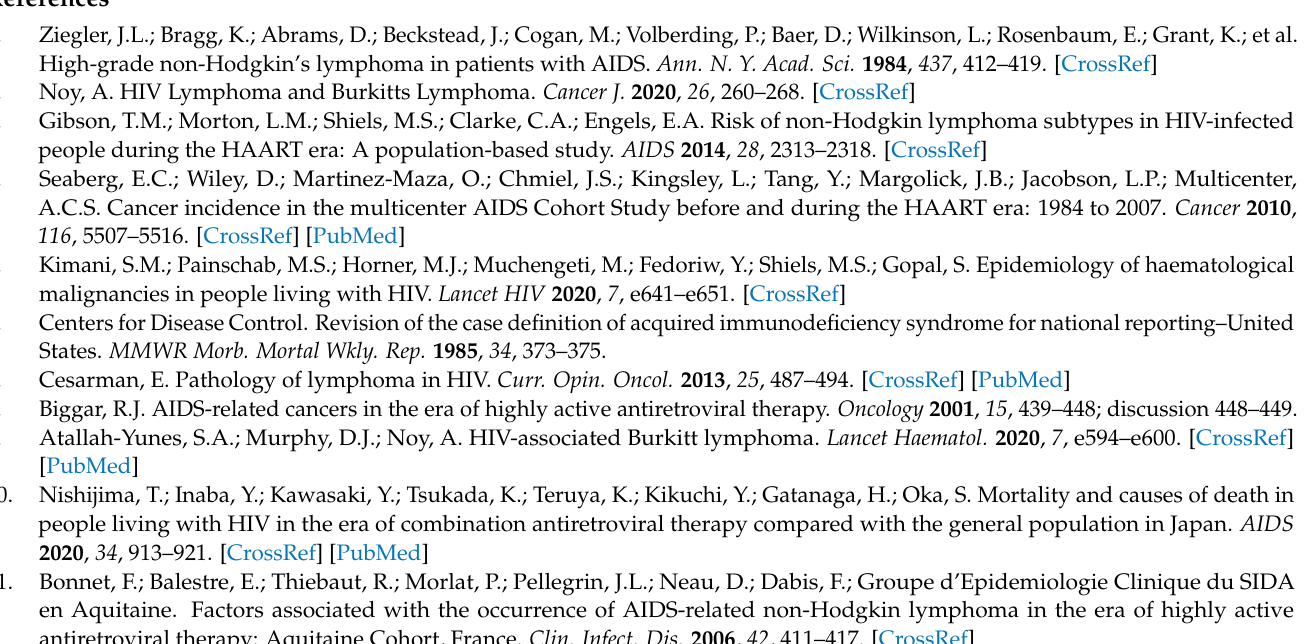
Figure S8: Efficacy of ch128.1/IgG1 in the disseminated model of AIDS-NHL using JB